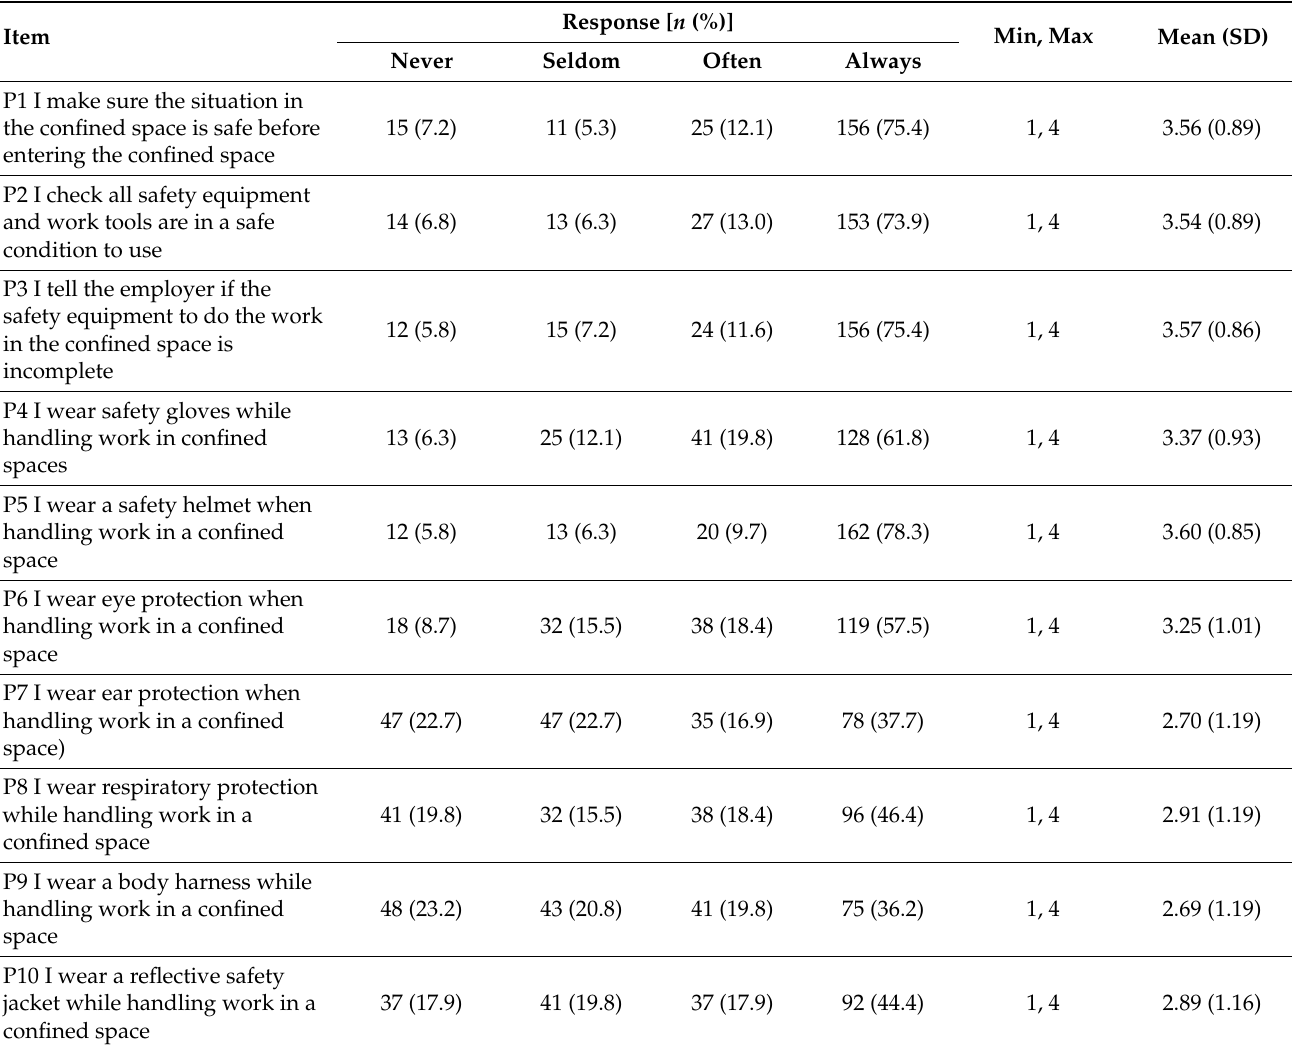
Table 3. Descriptive statistics of practice on safe working in a confined space among water services workers ( n =